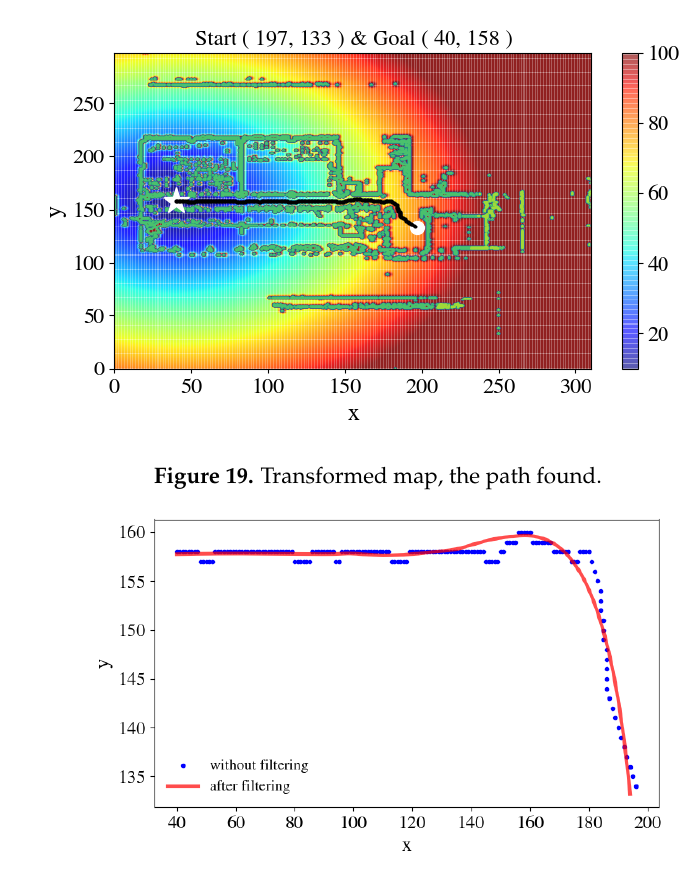
Figure 20. Transformed map before and after